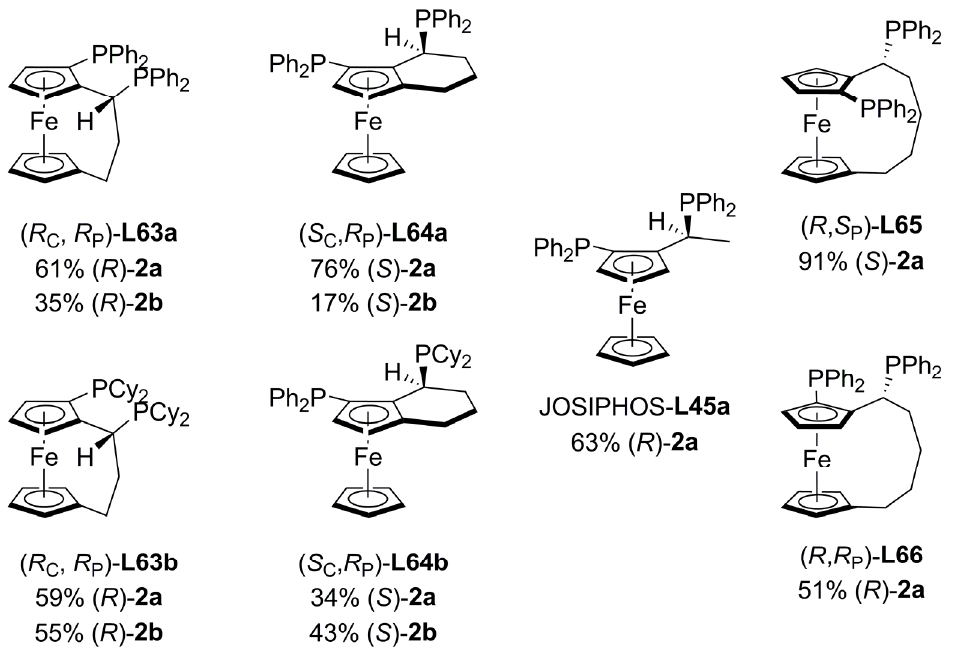
Figure 23. Annularly bridged ferrocenyl